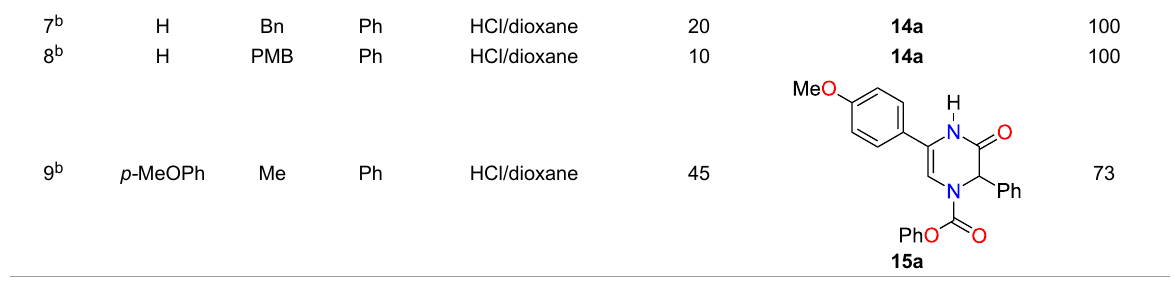
Table 2: Conversion of dihydropyrazine to Δ 5 -2-oxopiperazines under acidic conditions. (continued) 7 b